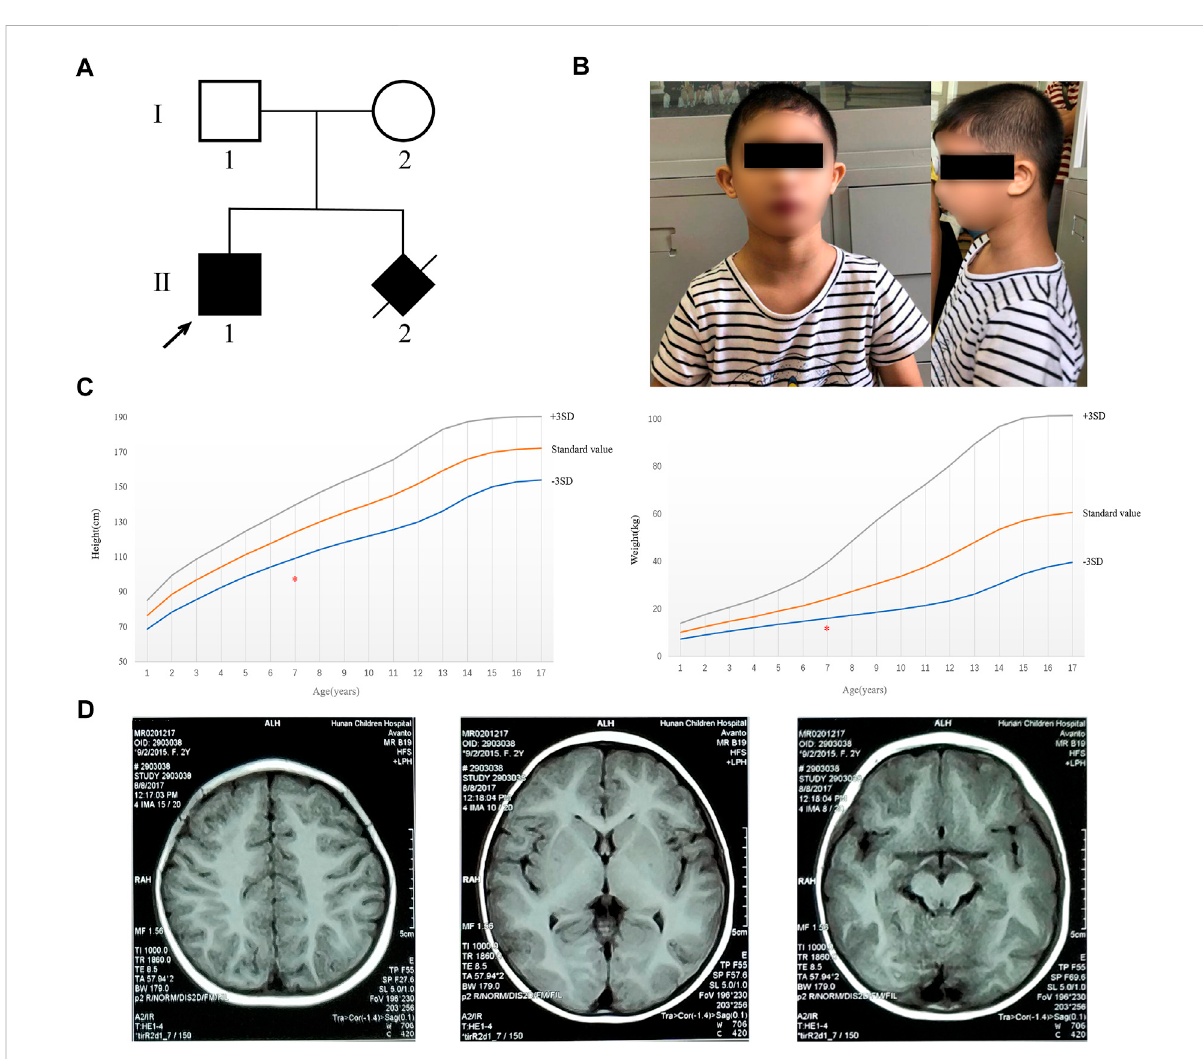
FIGURE 1 Pedigreeofthefamilyandclinicalcharacterizationoftheproband. (A) Pedigreeofthefamily.Filledblacksymbolsindicatetheaffectedsubjects. Thearrowindicatestheprobandinourstudy. (B) Clinicalcharacteristicsoftheproband(includingmicrocephaly,shortstature,slopingforehead,high nasal bridge, beaked nose, and retrognathia). (C) Height and weight of the proband are marked with the red asterisk and were less than 3 SD of the standard value of people of the same age. (D) MRI result demonstrated that no abnormality was